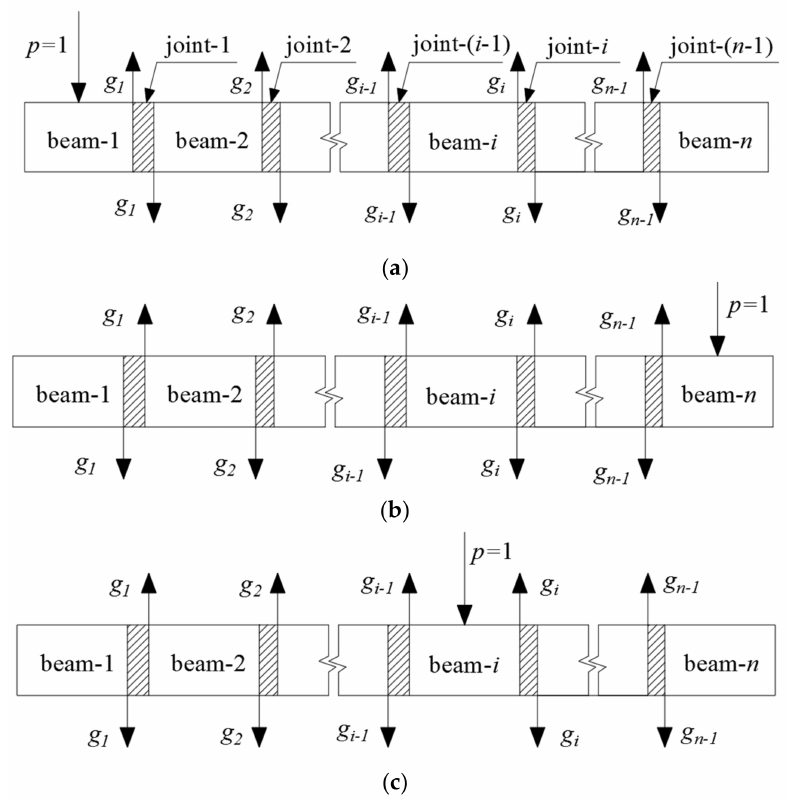
Figure 2. ( a ) Force analysis diagram when external load p = 1 applied on beam-1. ( b ) Force analysis diagram when external load p = 1 applied on beam- n . ( c ) Force analysis diagram when external load p = 1 applied on beam- i